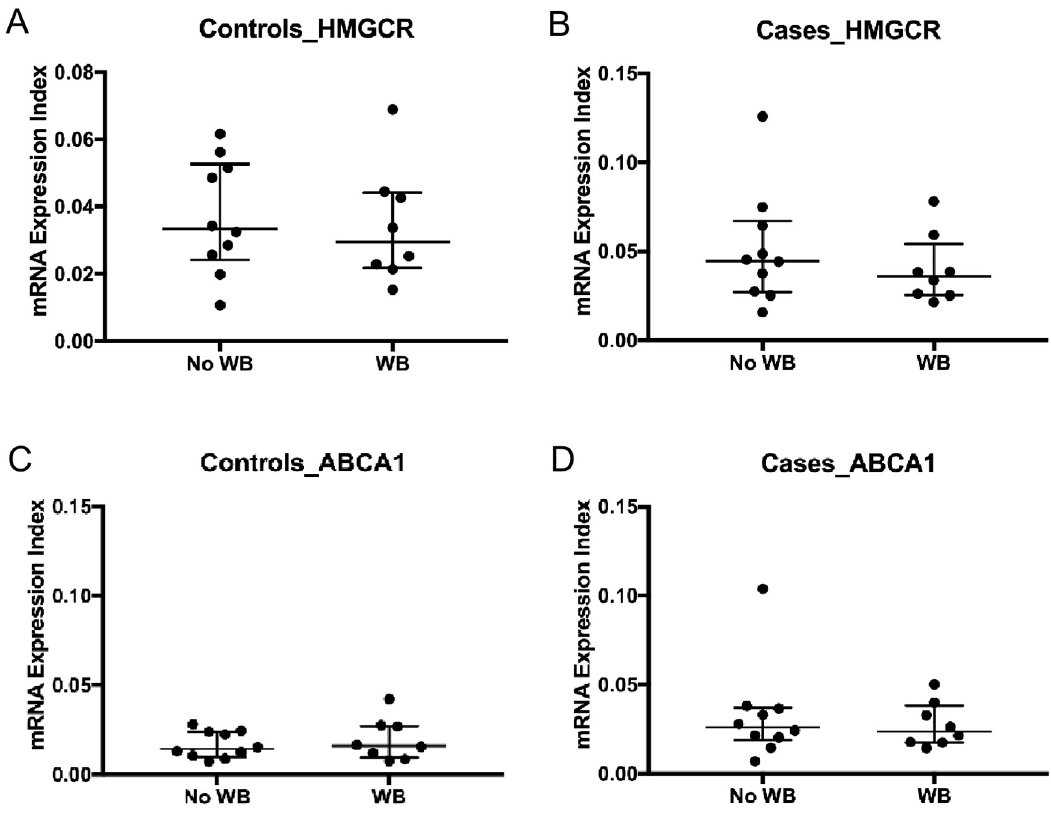
Fig 2. mRNA expression levels in patients with protein expression level results (western blots (WB)) compared to those without (No WB) to determine whether included participants were comparable to excluded participants. A. Controls- mRNA expression comparison of HMGCR. B. Cases- mRNA expression comparison of HMGCR. C. Controls- mRNA expression comparison of ABCA1. D. Cases- mRNA expression comparison of ABCA1. n = 10 (No WB-), n = 8 (WB). Data are median (25 th – 75 th percentiles of interquartile range), p values represent Wilcoxon matched-pairs signed-rank test, with significance being p < 0.05.